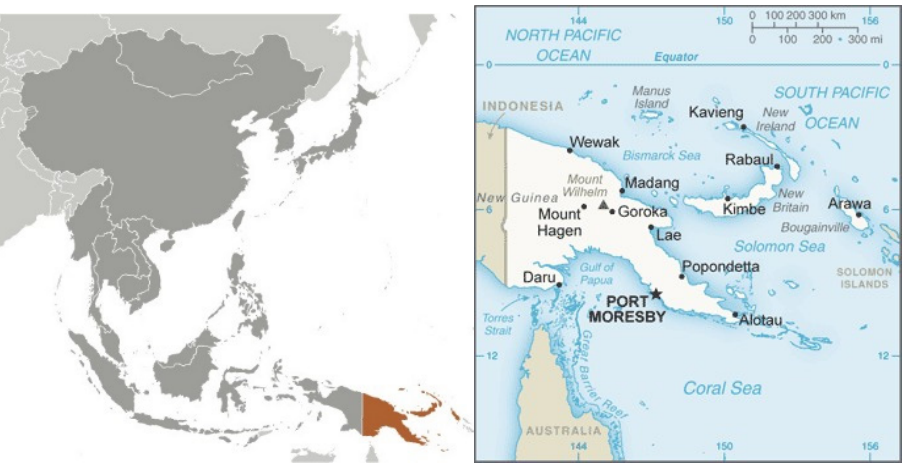
Diversity 2021 , 13 , x FOR PEER REVIEW Figure 1. Regional map and major landmarks of PNG. From CIA World Factbook Figure 1. Regional map and major landmarks of PNG. From CIA World Factbook [https://www.cia.gov/library/ [https://www.cia.gov/library/publications/the-world-factbook/geos/pp.html (accessed on 3 June publications/the-world-factbook/geos/pp.html (accessed on 3 June 2021)]. 2021].